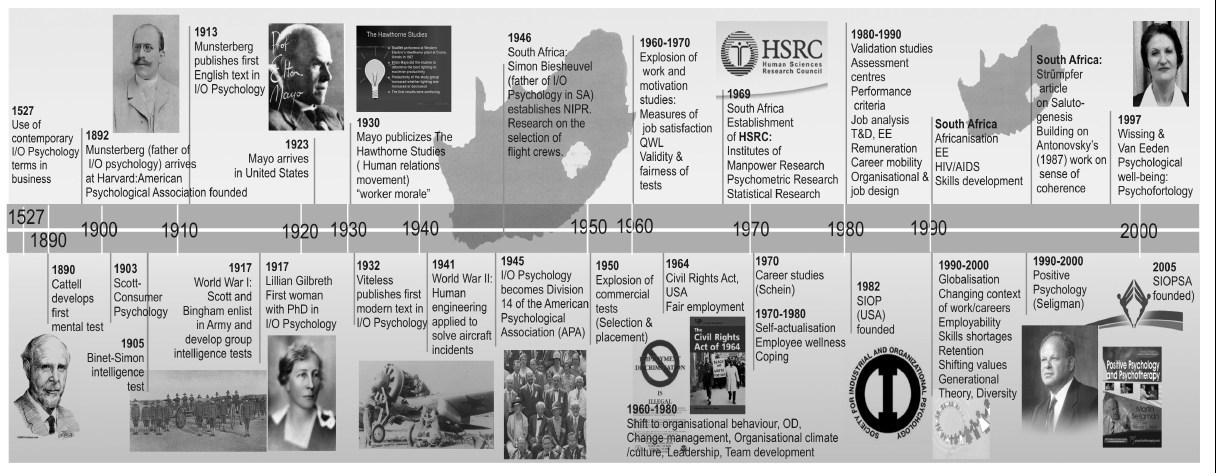
FIGURE 1 Overview of the historical evolution of Industrial and organisational